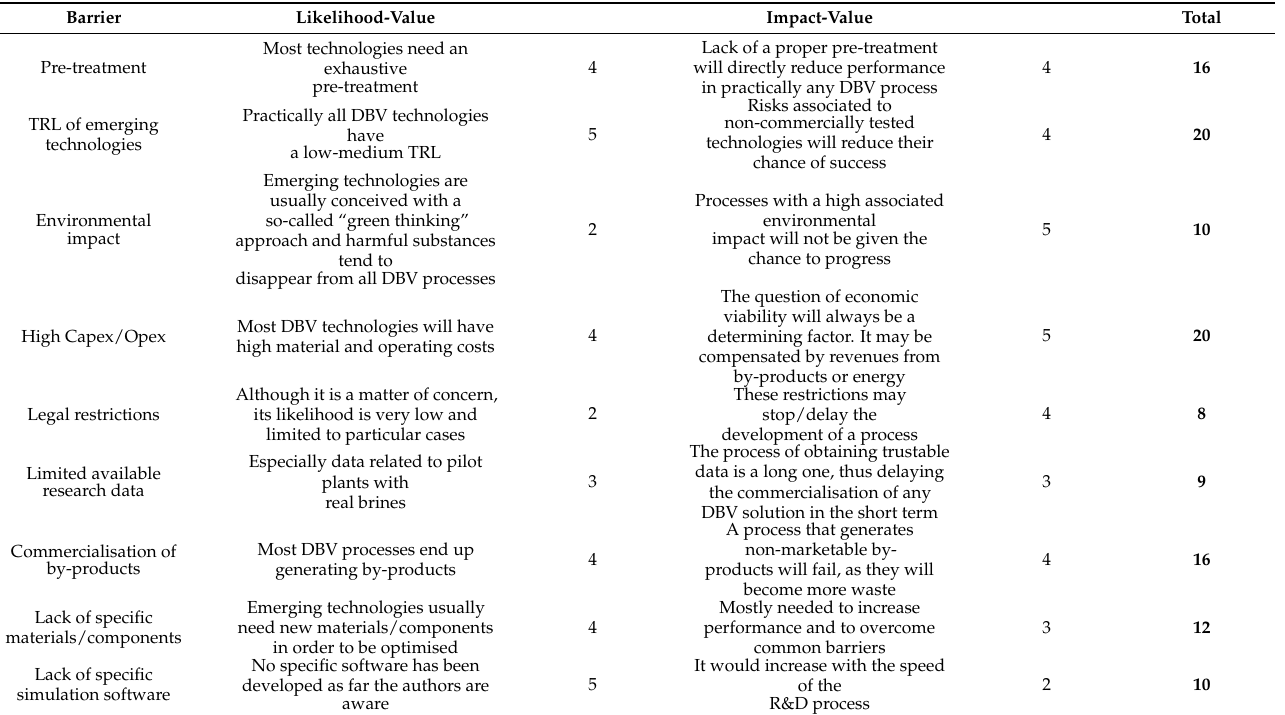
Table 7. Evaluation of the likelihood and the impact of a list of identified barriers for DBV industriali-